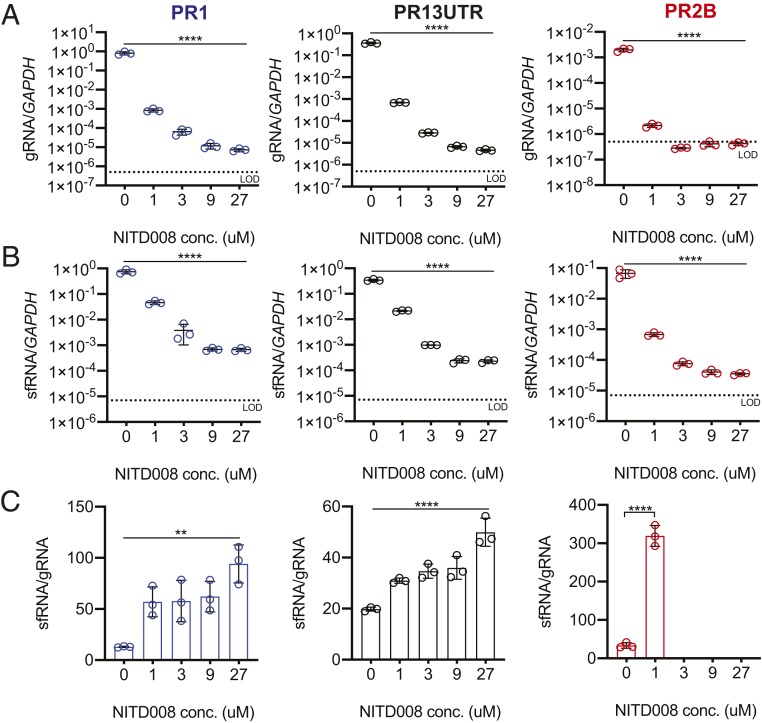
Reduced gRNA replication is required for an increased sfRNA:gRNA ratio. Quantification of gRNA levels (A), sfRNA levels (B), and sfRNA:gRNA ratios (C) in A549 cells with cotreatment of NITD008 at increasing concentrations. Ratios of sfRNA:gRNA were not calculated when the gRNA levels were at or below the limit of detection (LOD). Data are presented as mean ± SD. **P < 0.01; ****P < 0.00001, one-way ANOVA.